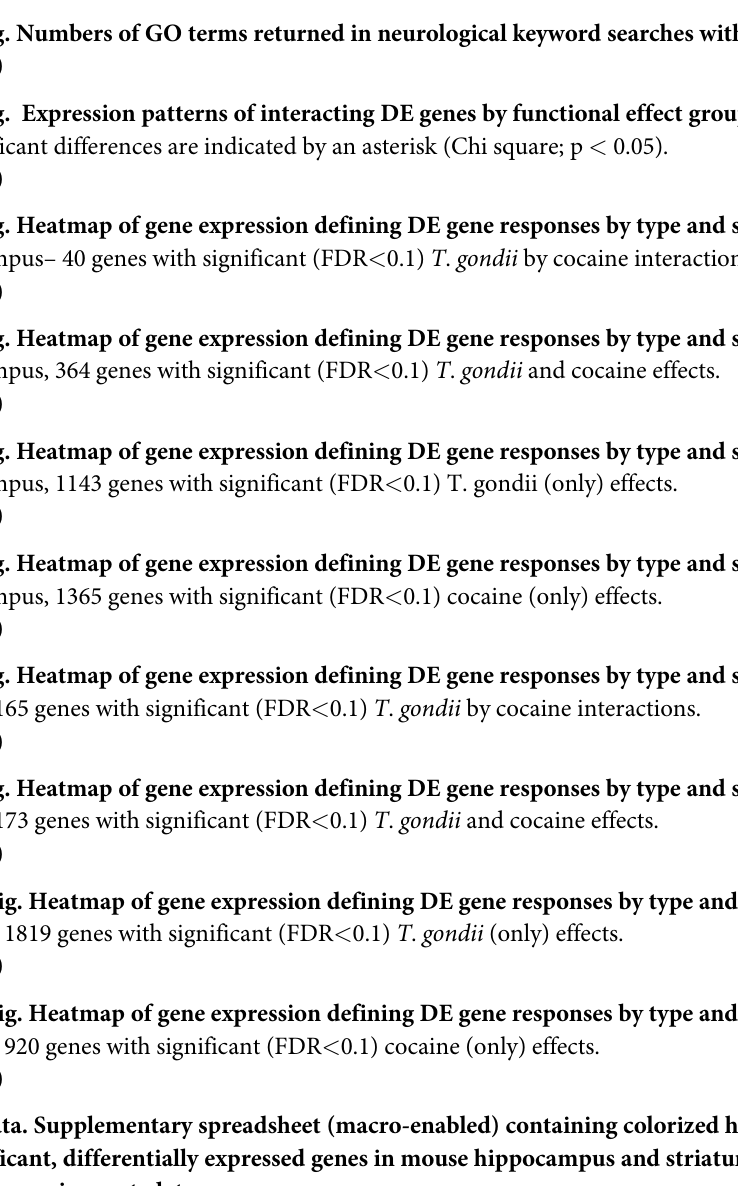
S2 Fig. Numbers of GO terms returned in neurological keyword searches with overlaps. S3 Fig. Expression patterns of interacting DE genes by functional effect group (A to H). Significant differences are indicated by an asterisk (Chi square; p < 0.05). S4 Fig. Heatmap of gene expression defining DE gene responses by type and subtype. Hip- pocampus– 40 genes with significant (FDR < 0.1) T . gondii by cocaine interactions. S5 Fig. Heatmap of gene expression defining DE gene responses by type and subtype. Hip- pocampus, 364 genes with significant (FDR < 0.1) T . gondii and cocaine effects. S6 Fig. Heatmap of gene expression defining DE gene responses by type and subtype. Hip- pocampus, 1143 genes with significant (FDR < 0.1) T. gondii (only) effects. S7 Fig. Heatmap of gene expression defining DE gene responses by type and subtype. Hip- pocampus, 1365 genes with significant (FDR < 0.1) cocaine (only) effects. S8 Fig. Heatmap of gene expression defining DE gene responses by type and subtype. Stria- tum, 165 genes with significant (FDR < 0.1) T . gondii by cocaine interactions. S9 Fig. Heatmap of gene expression defining DE gene responses by type and subtype. Stria- tum, 173 genes with significant (FDR < 0.1) T . gondii and cocaine effects. S10 Fig. Heatmap of gene expression defining DE gene responses by type and subtype. Stri- atum, 1819 genes with significant (FDR < 0.1) T . gondii (only) effects. S11 Fig. Heatmap of gene expression defining DE gene responses by type and subtype. Stri- atum, 920 genes with significant (FDR < 0.1) cocaine (only) effects. S1 Data. Supplementary spreadsheet (macro-enabled) containing colorized heatmap